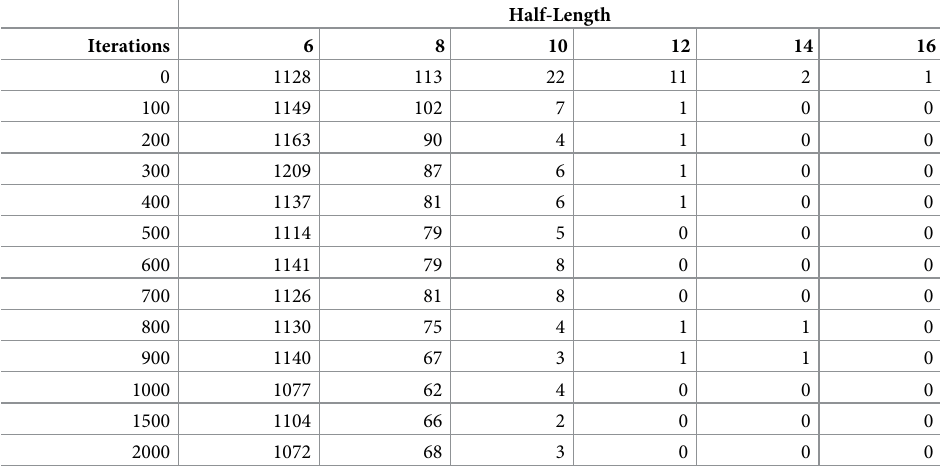
Table 3. Numbers of palindromes as a function of Mason_variator iterations. The genome is E. coli . Half lengths of 6, 8, 10, 12, 14 and 16 are columns and Mason_variator iterations are